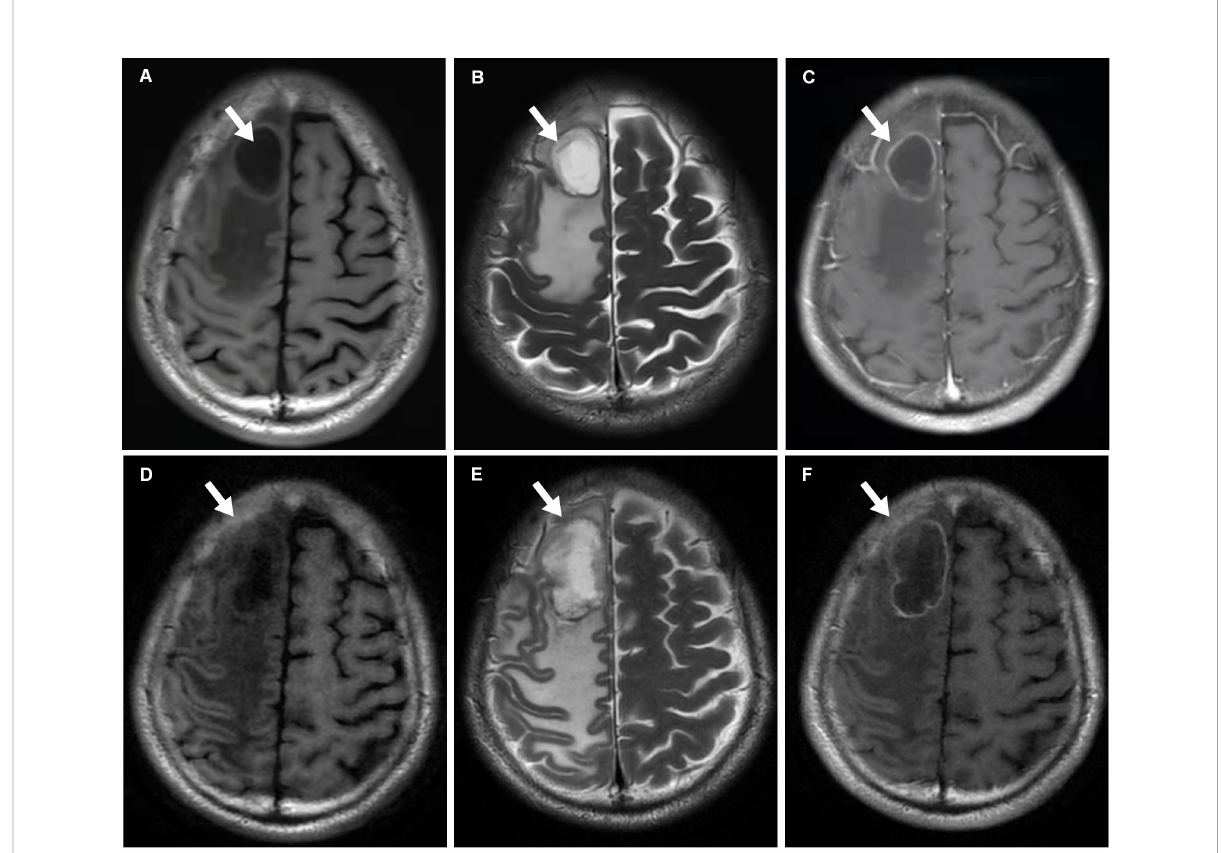
FIGURE 2 MRI scans. (A – C) In October 2021, T1-weighted (Panel A ), T2-weighted (Panel B ) and T1+C (Panel C ) MRI scans reveal metastasis with cystic change and annular enhancement in the right frontal lobe (arrows). (D – F) After one cycle ICIs treatment, T1-weighted (Panel D ), T2-weighted (Panel E ) and T1+C (Panel F ) MRI fi ndings show that the tumor (arrows)